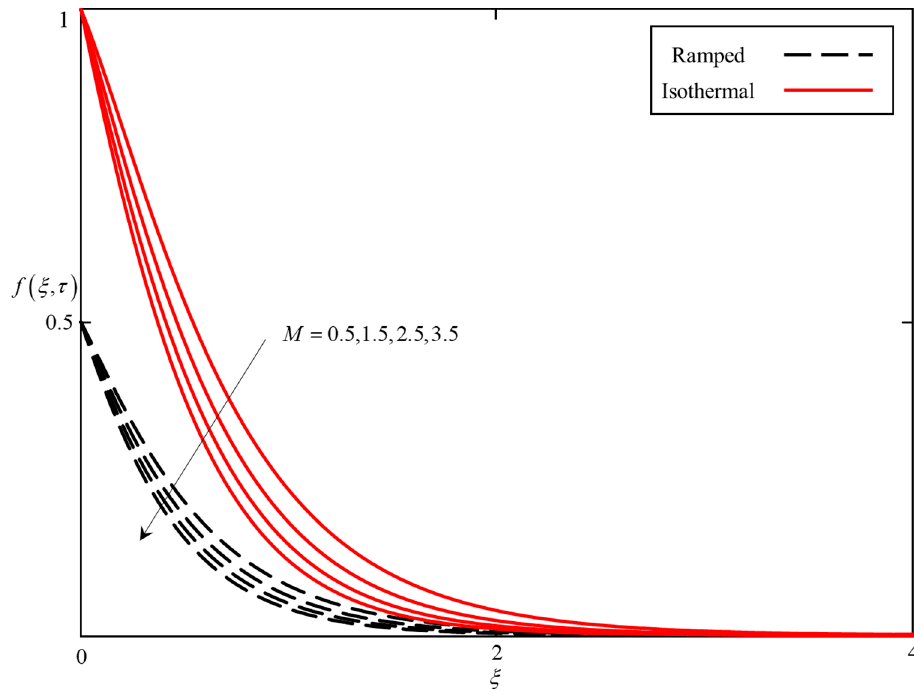
Figure 12. Consequence of M on the velocity field, when α = 0.5, β = 0.5, φ = 0.04, λ 1 = 0.5, λ 2 = 0.5, K = 0.5, Pr = 21, and Gr = 5.0.